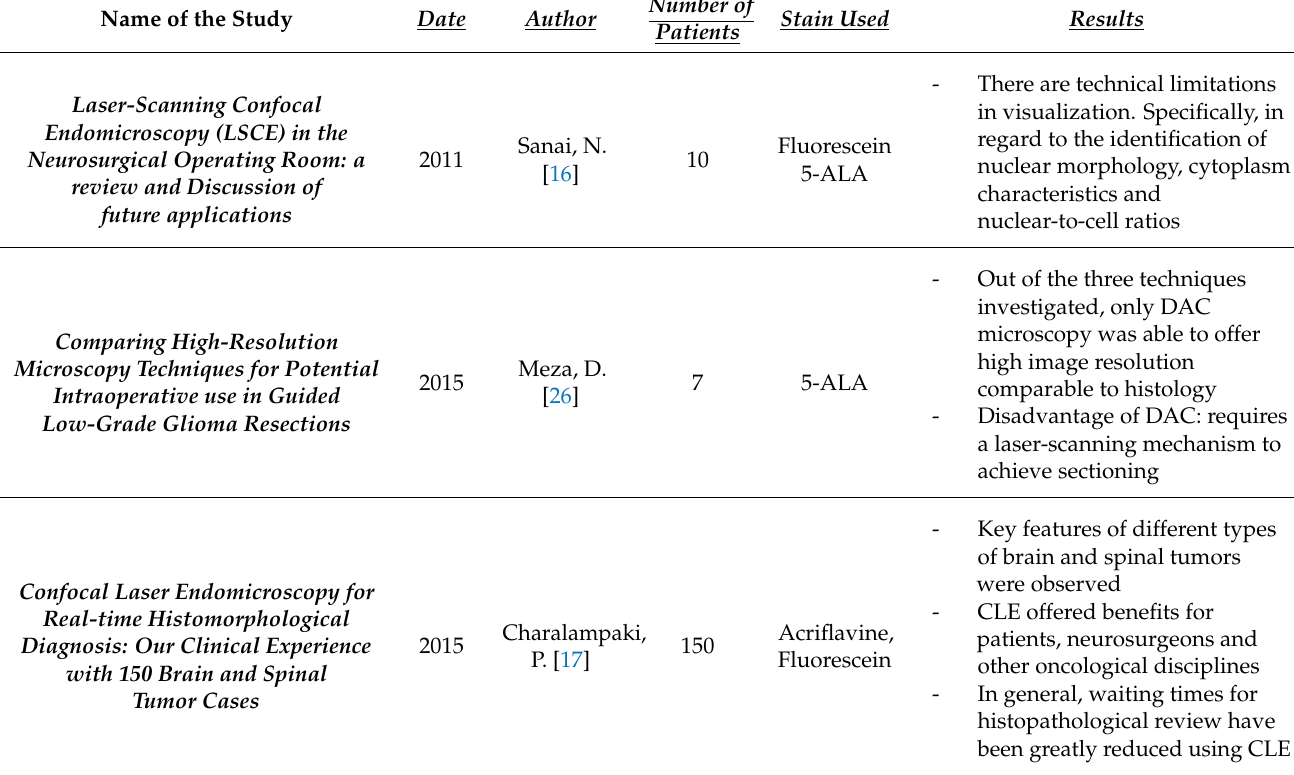
Table 1. Intraoperative use of CLE in